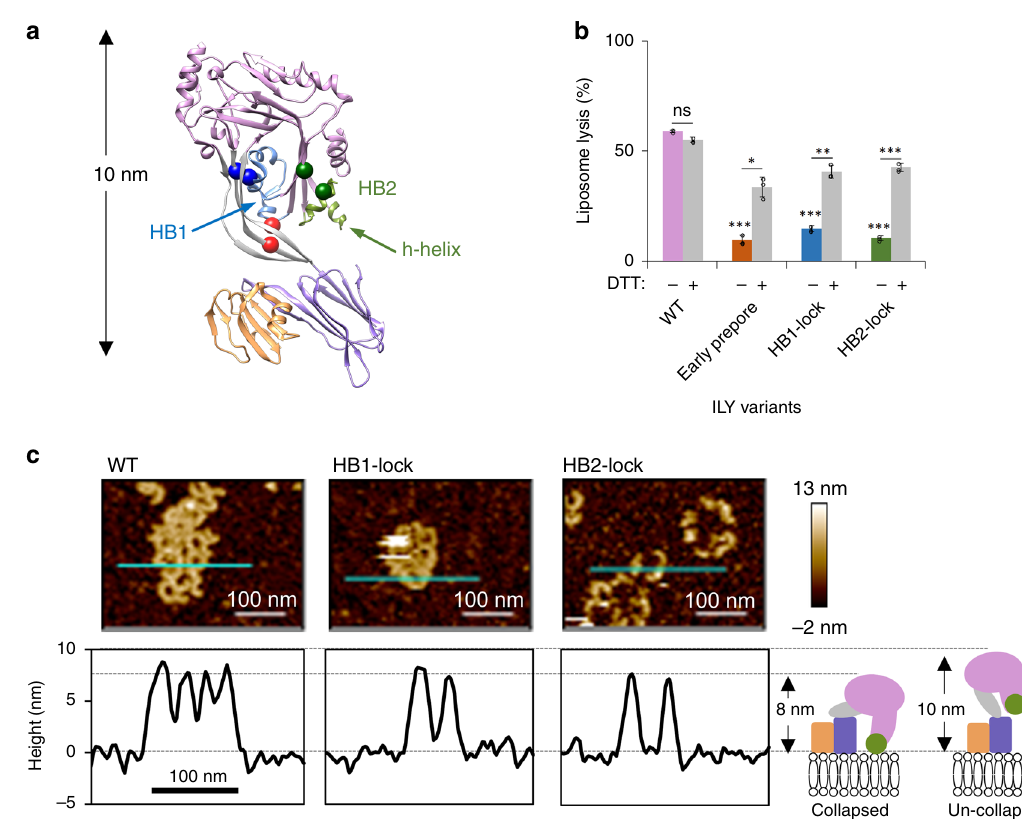
Fig. 2 Trapping pore formation of collapsed ILY oligomers. a Early prepore showing CD59 (orange) and ILY colored by domains: MACPF/CDC (pink), D2 (gray), D4 (purple). Domains 1 and 3 of ILY are grouped within the MACPF/CDC. HB1 (blue) and HB2 (green) are two helical bundles that form transmembrane β -hairpins in the fi nal pore. Horizontal helix (h-helix) of HB2 is indicated (green arrow). Introduced cysteines (spheres) that form disul fi de- bonds to trap conformations: early prepore (red), HB1-lock (blue) and HB2-lock (green). b A fl uorescence-based calcein-release assay was used to test lysis of liposomes containing cholesterol and CD59. ILY variants (wild-type (WT), early prepore, HB1-lock and HB2-lock) were analyzed for activity with and without reducing agent (DTT) pretreatment after 45 min. The statistical signi fi cance of this comparison is indicated above a horizontal line. Statistical signi fi cance displayed above each -DTT bar is for comparisons against wild-type ILY without reducing agent. Individual data points from three independent experimental assays are shown as circles. Error bars represent standard deviation with the center of the bar indicating the mean value. P -value signi fi cance determined by 2-way ANOVA with a Bonferroni post-test: ns, not signi fi cant; * p < 0.05; ** p < 0.01; *** p < 0.001. c AFM images (top) visualizing ILY variants on supported lipid bilayers containing cholesterol and CD59. Cyan line indicates image positions of height pro fi les (bottom) for ILY variants. White scale bar, 100 nm. Average assembly height and standard deviation was measured from 10 such pro fi les for each ILY variant: HB1-lock (7.9 nm±0.6), HB2-lock (7.9 nm±0.4), and WT (8.4 nm±0.6). Schematic illustrates the domain organization (colored as in panel a ) and vertical collapse measurements for ILY